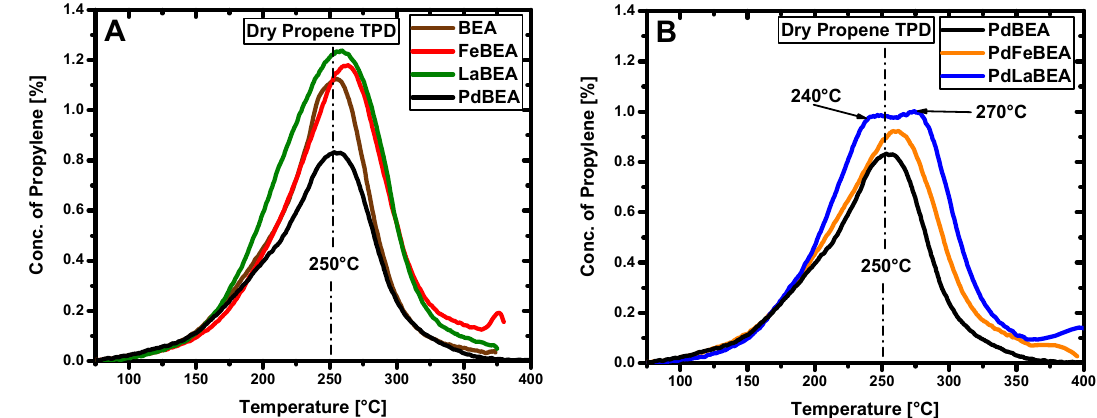
Figure 4. Temperature-programmed desorption (TPD) of propene at dry conditions where the concentration of propene is plotted against the corresponding desorption temperature during the heating ramp. The samples were pre-oxidized at 400 ◦ C. The desorption profiles for ( A ) BEA, Fe / BEA, La / BEA and Pd / BEA; and for ( B ) Pd / BEA, Pd / Fe / BEA and Pd / La / BEA are shown. ◦ After the propene TPD, the sample was oxidized using 10% O 2 at 400 C for 20 min. The formed CO and CO 2 show that some residual carbon remained on the surface after the TPD. The distribution of C 3 H 6 , CO, and CO 2 during desorption is shown in Table 2, where the components are translated into